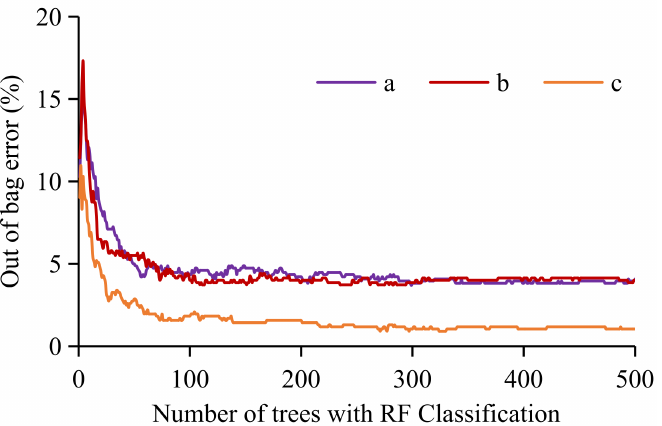
Figure 9. Out-of-bag (OOB) error plot versus number of trees (NT) with RF modeling: (a) simple nu- meric labeling (SNL)-based RF modeling using TS1, (b) weight assignment (WA)-based RF modeling using TS1, and (c) frequency ratio (FR)-based RF modeling using TS2.